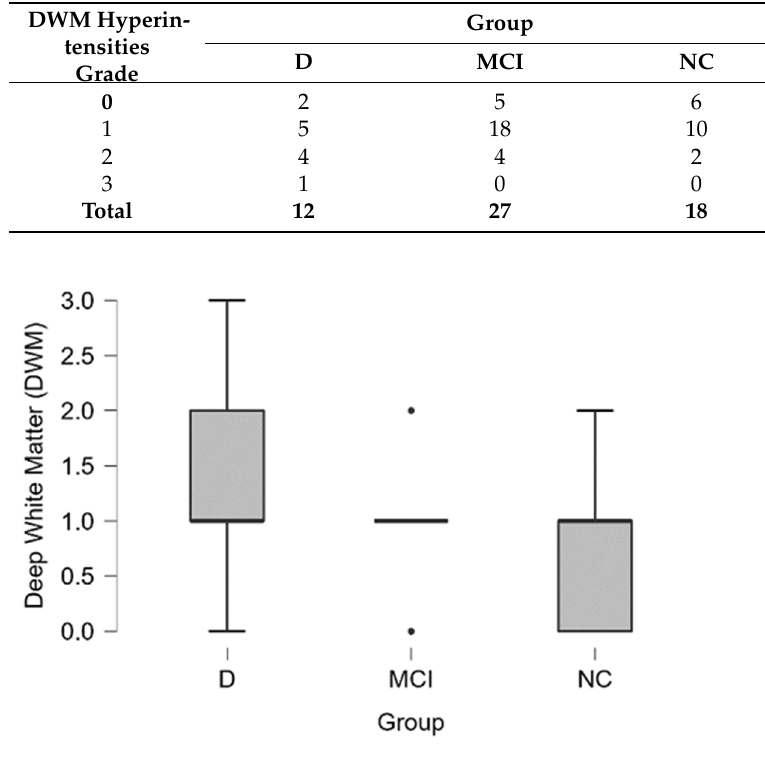
Figure 8. DWM hyperintensities grade boxplot in (from left to right) dementia, MCI, and normal cognition groups (black dot–outlier). cognition groups (black